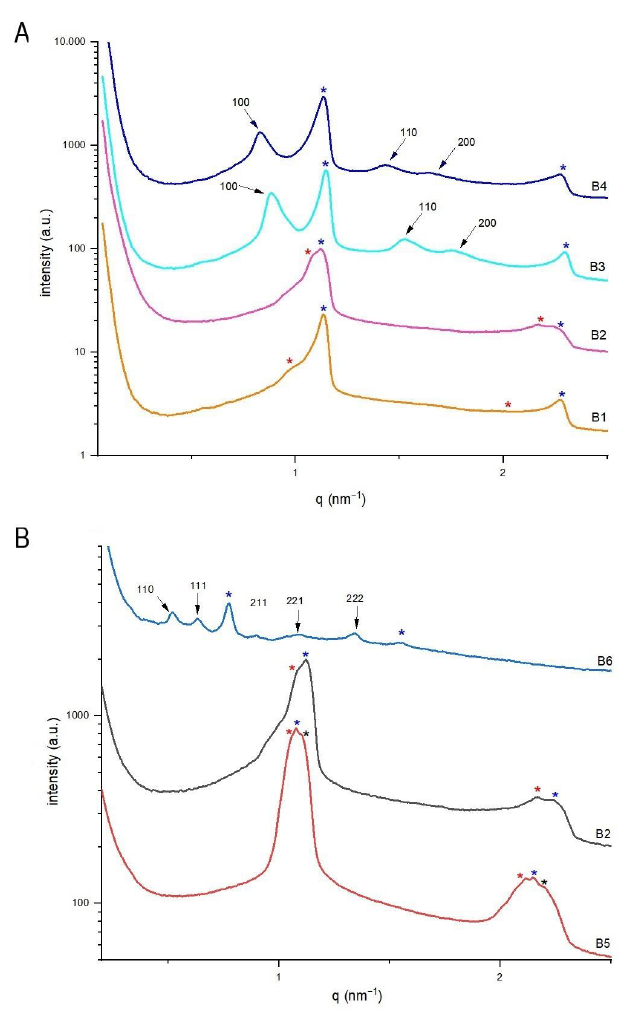
Figure 3. Effects of TQ and ethanol concentrations at 25 °C on the structural features of citrem/SPC nanodispersions prepared using the low energy-emulsification batch method. ( A ) SAXS patterns of samples prepared at TQ concentrations in the range of 1–10 mg/mL. The nanodispersions (B1–B4) were prepared at citrem/SPC weight ratio of 2:3 and constant EtOH and lipid (SPC plus citrem) concentrations of 1.09 and 8.0 wt%, respectively. ( B ) SAXS patterns of 2:3 citrem/SPC nanodispersions prepared at a constant TQ concentration of 2.5 mg/mL and contained different concentrations of ethanol (in the range of 0–5.45 wt%, Table 2). The detected Bragg peaks and corresponding Miller indices for the inverse bicontinuous cubic Pn3m ( A ) and inverse hexagonal (H 2 ) phases ( B ) are presented and marked with arrows. In panels A and B, the detected two characteristic peaks for the two coexisting L α(1) and L α(2) phases are marked with red and blue asterisks, respectively. The two characteristic peaks of the coexisting third lamellar phase (L α(3) phase) detected in sample B5 is marked with black asterisks.